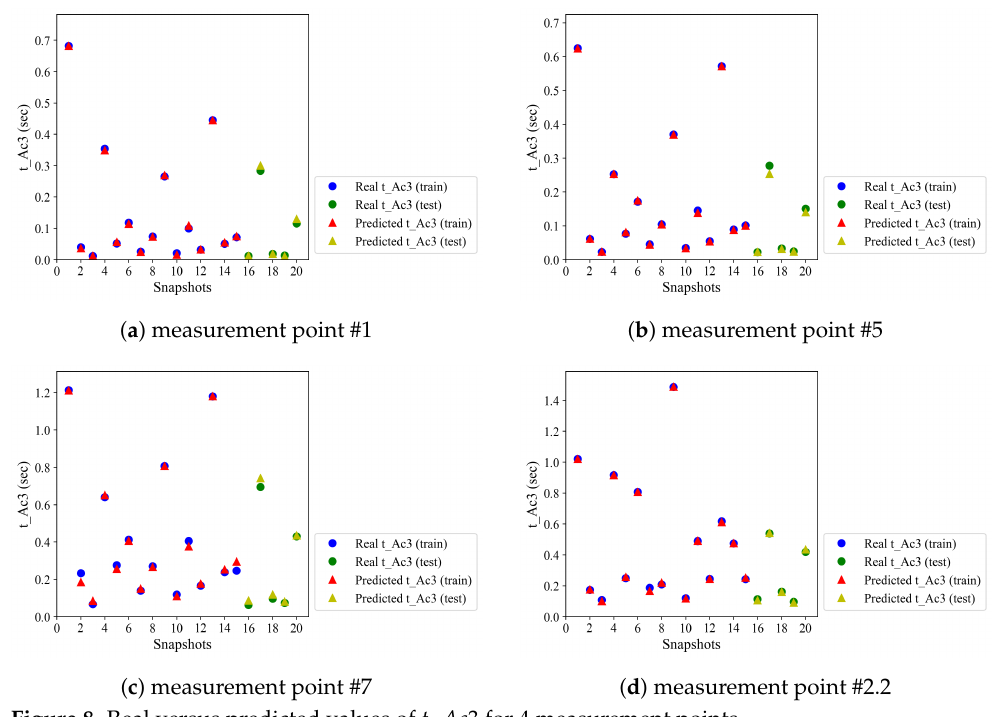
Figure 8. Real versus predicted values of t _ Ac 3 for 4 measurement points.